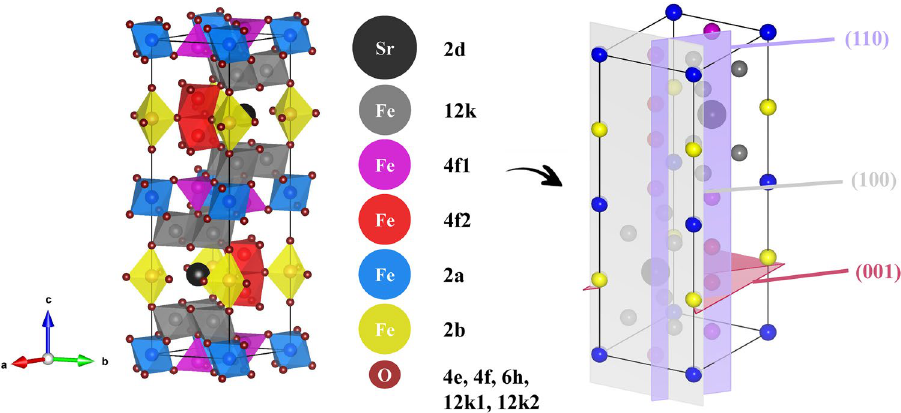
Figure 1. Illustration by VESTA 13 of the unit cell of SrFe 12 O 19 (space group P6 3 /mmc ).